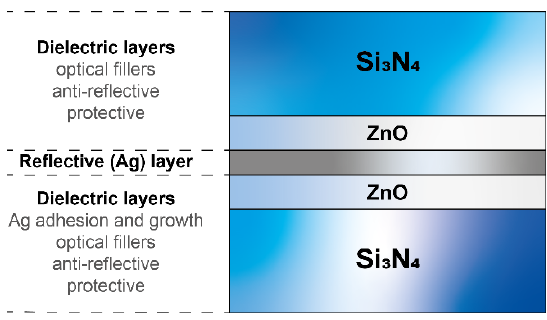
Figure 1. Typical silver-based low-emissivity (low-E) coating five-component stacking scheme. The thickness of the reflective layer has values of about 10 nm, while that of the dielectric layers could vary based on designed performances for the film. Coatings with multiple reflective layers are deposited following the five-component basic layer sequence.